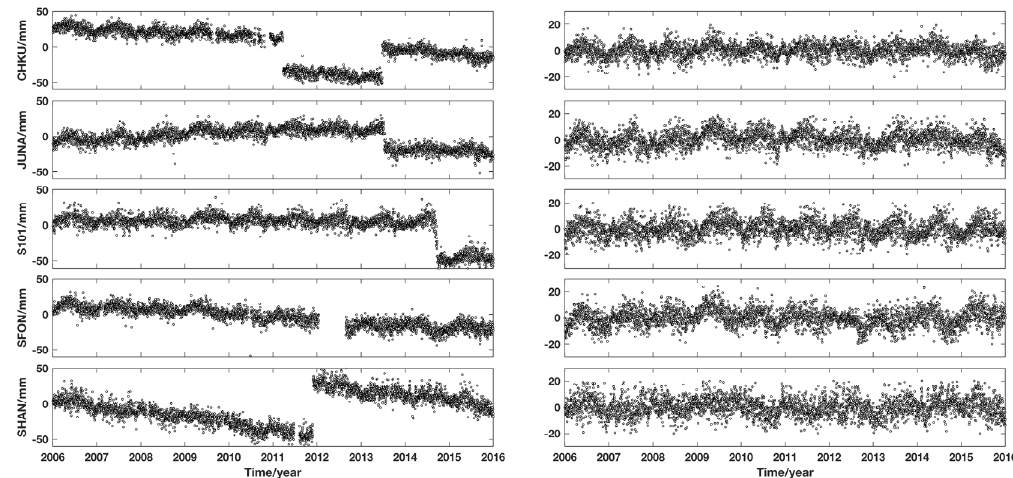
Figure 3. Original GPS time series ( left ) and preprocessing sequence of the CHKU, JUNA, S101, SFON, and SHAN stations ( right ).